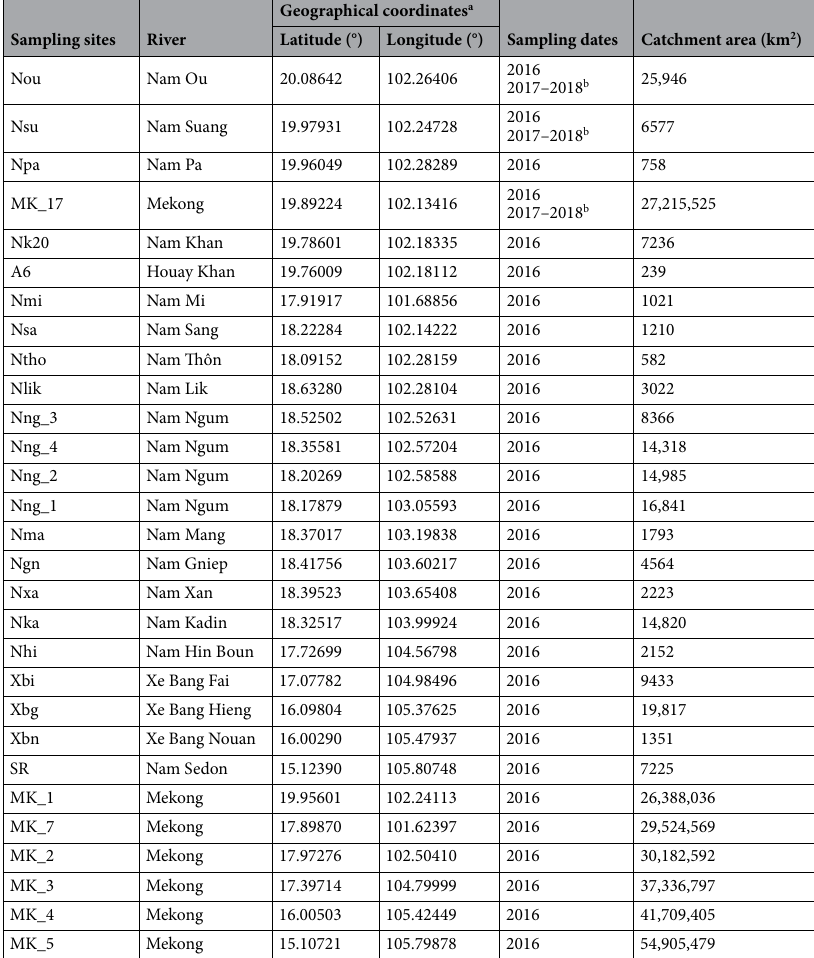
Table 1. Description of sampling sites in Lao PDR: names of river, geographical coordinates of sampling sites (i.e., latitude and longitude in degrees, WGS 1984) , sampling dates during field surveys in March and July 2016, and regular monitoring from July 2017 to December 2018, and catchment drainage area in km 2 . a Geographical coordinates in degrees (WGS 1984). b Sampling frequency of 10-days